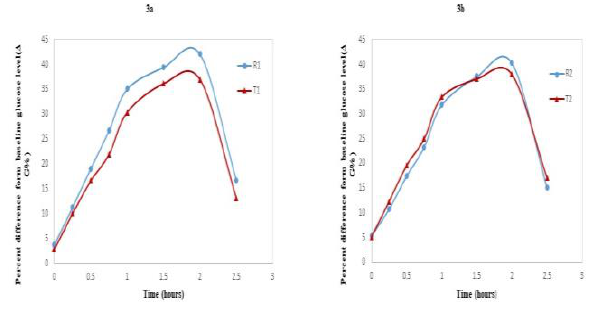
Fig. 2. Geometric Mean Plasma Concentration-time profile of Metformin 500 mg (2a) or 1000 mg (2b) alone (R1&R2) and with daclatasvir 60 mg (T1&T2)